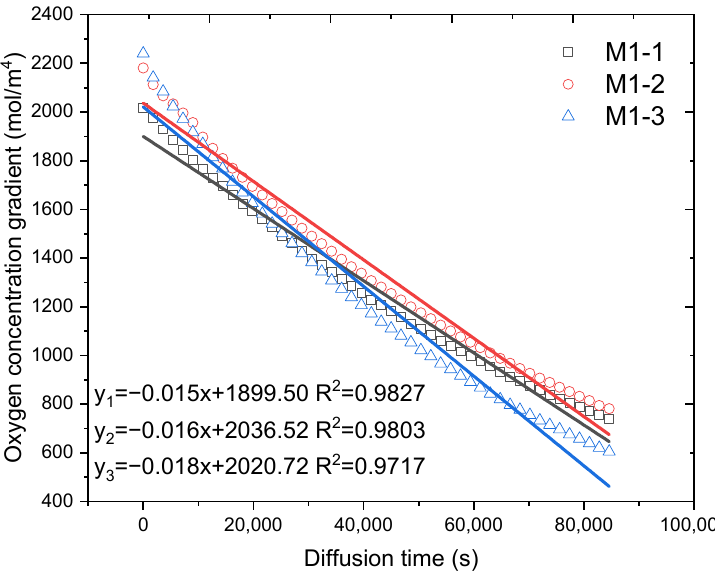
( a ) Oxygen concentration gradient change in terms of diffusion time of C1 samples.